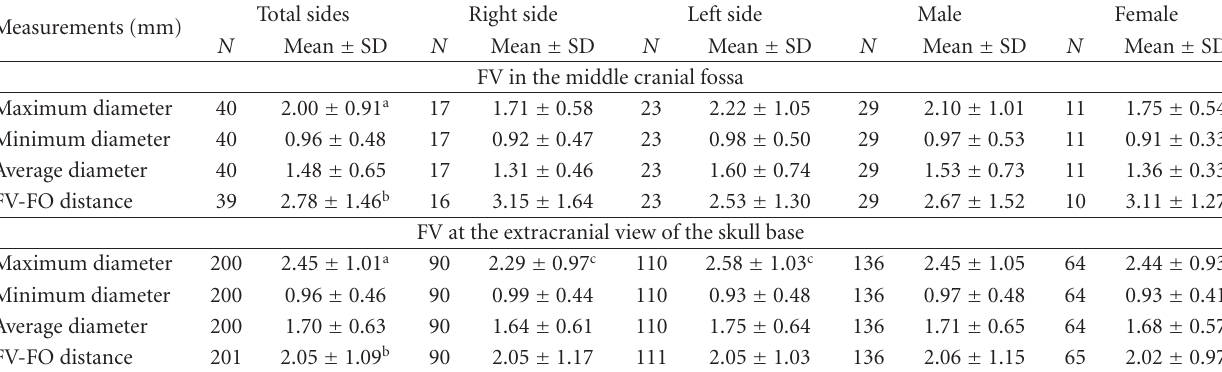
Table 3: Comparison the diameters of FV and the distance between FV and FO according to sides and sexes. Total sides Right side Left side Measurements (mm)